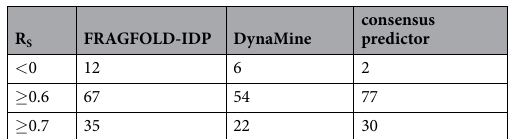
Table 1. Good and excellent predictions produced by the